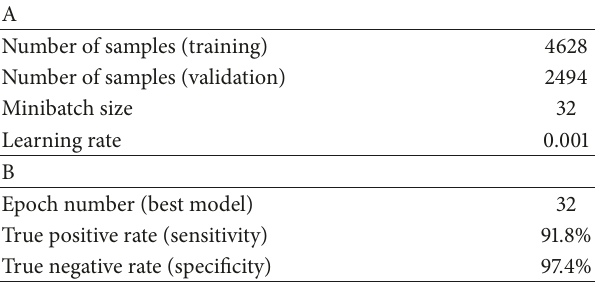
Table 1: In section A, the parameters to train the model are summarized. Section B shows the performance parameters of the DCNN model when applied to the validation